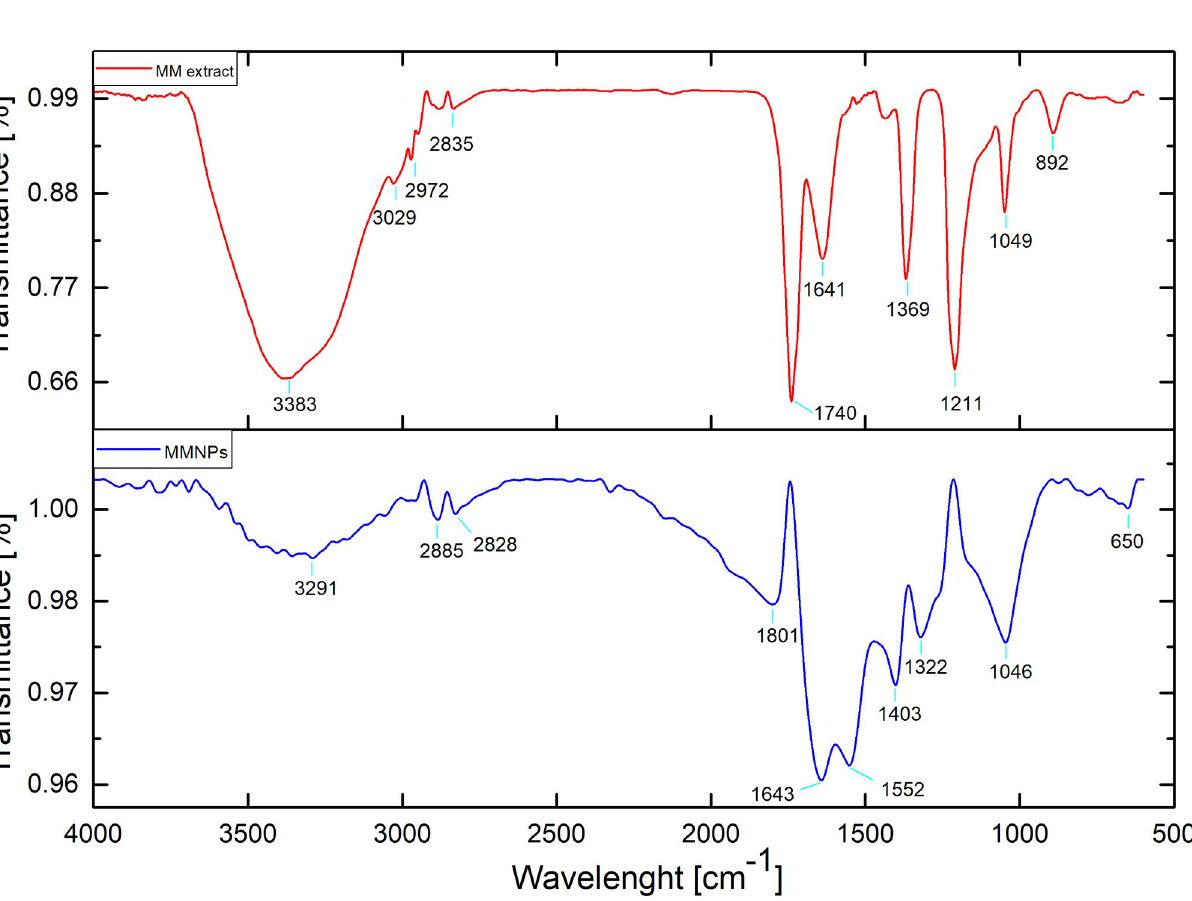
Fig 5. FTIR pattern of the Mang Mao wings extract and synthesized MMAgNPs.